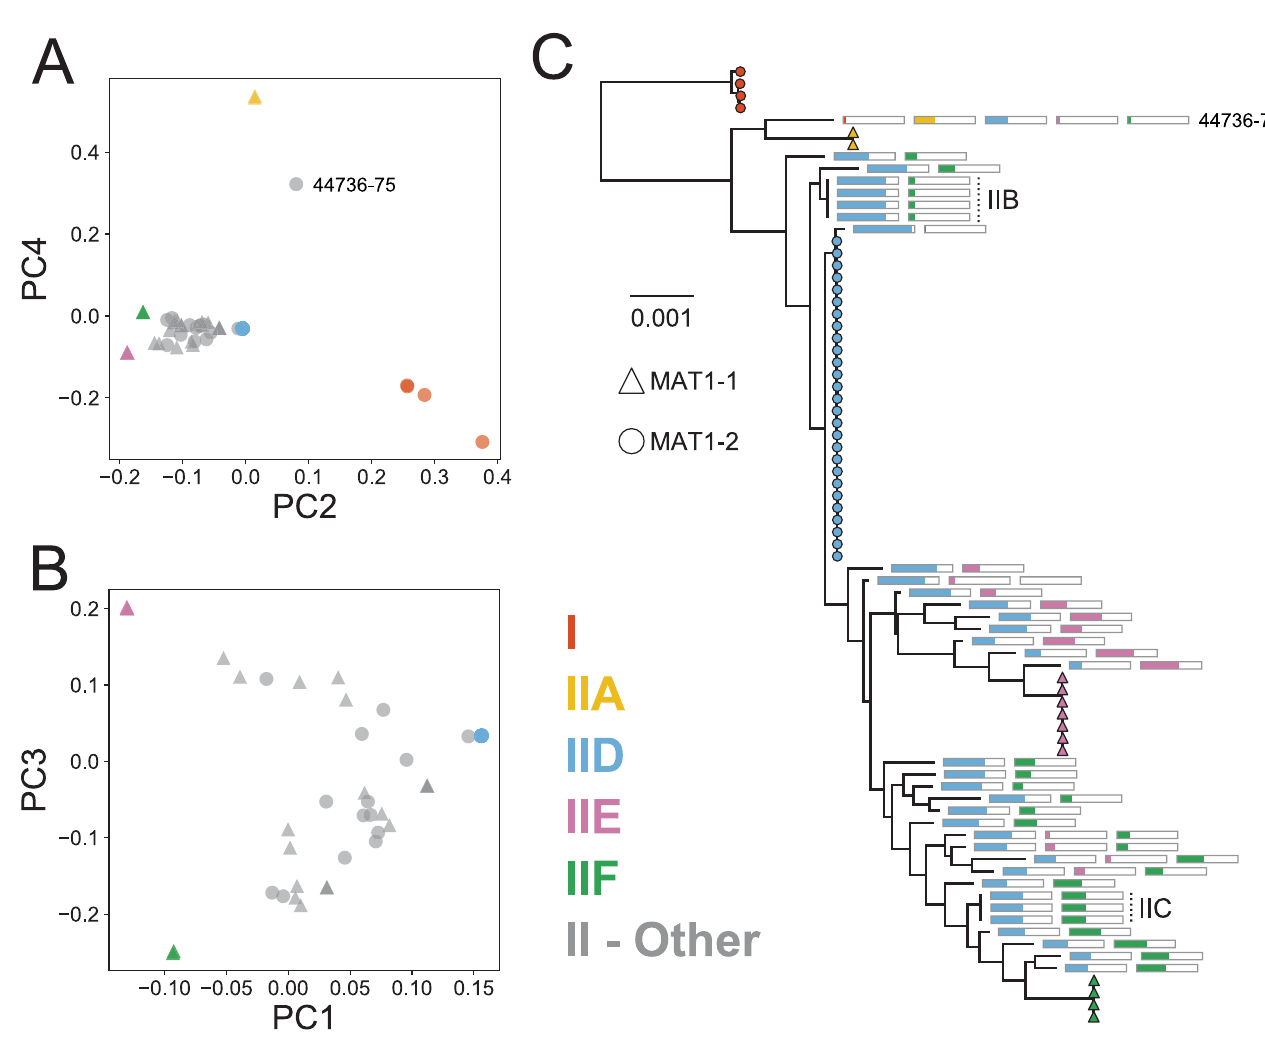
Fig 2. Many North American strains of Ophidiomyces ophiodiicola are recombinants between clonal lineage IID and clonal lineages IIE and/or IIF. ( A) and (B) illustrate the genetic similarity among the strains of Clades I and II based on a co-ancestry matrix generated using ChromoPainter and visualized through PCs 1–4. Panel (A) includes all 79 strains, while the strains of Clade I and clonal lineage IIA, as well as strain NWHC 44736–75, have been excluded from panel (B). Shapes indicate the mating type of each strain. Strains from nonrecombinant clonal lineages are indicated by colored shapes, recombinant strains are shown in gray. (C) Nuclear maximum-likelihood phylogeny (same as shown in Fig 1C) with colored bars approximating the level of ancestry from each of the nonrecombinant clonal lineages. Strains belonging to nonrecombinant clonal lineages are indicated with colored shapes, with the shape indicating mating type. For recombinant strains, each bar represents a set of nuclear SNPs that are specific to 1 of the clonal, nonrecombinant lineages, and the proportion of the bar filled with color indicates the proportion of those SNPs that were also observed in that particular strain. A particular bar is only shown if the recombinant strain’s genome contained at least 1 SNP indicative of that clonal lineage. Colors are the same as those used in (A, B). Vertical dotted lines and labels indicate the recombinant clonal lineages. Data underlying this figure can be found in OSF: https://osf.io/fmbh5/. PC, principal component; SNP, single nucleotide